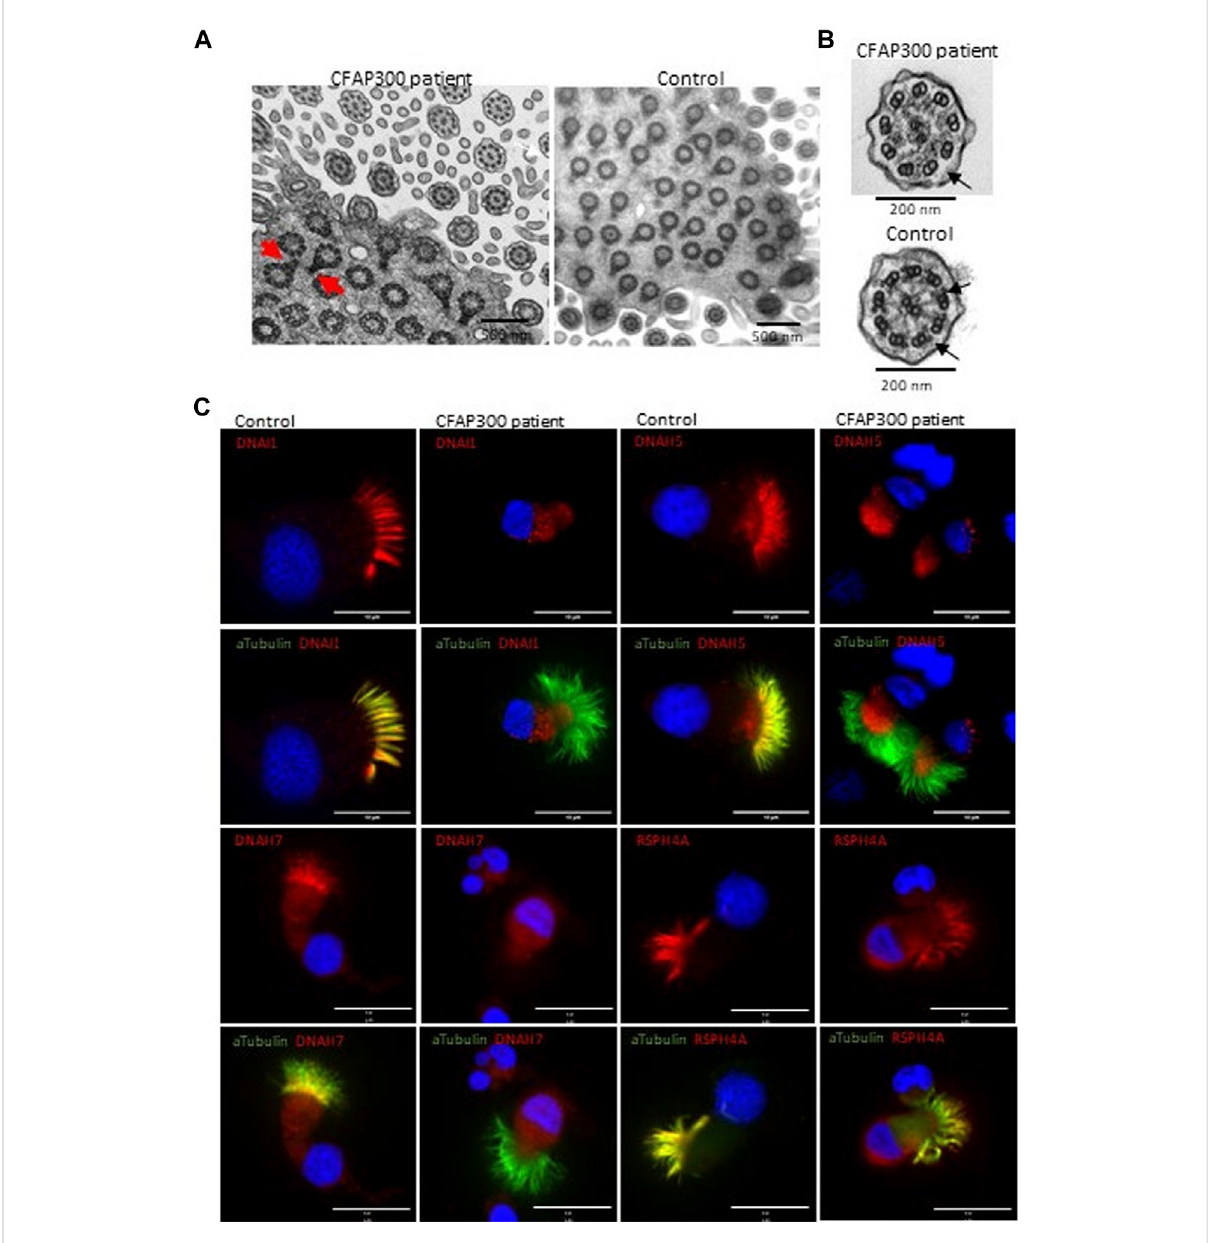
FIGURE 3 Localization of axonemal proteins in airway cilia of a control and PCD patient (patient II-1) with CFAP300 mutations. (A) . High number of cilia cross sections were present in the nasal brushing sample of a PCD patient with CFAP300 c.198_200delinsCC mutations, but the orientation of the basal foot (red arrows) was disorganized compared to control. (B) . The main fi nding in TEM of cilia cross sections in a patient with the CFAP300 variant was lack of dynein arms (black arrows). (C) . ODA (DNAH5 and DNAI1) and IDA (DNAH7) proteins were missing from cilia in the patient airway epithelial cilia, while strong staining is present in the control sample. Radial spoke protein RSPH4A is present in the patient cilia. α Tubulin was used as a marker for cilia and Dapi as a nuclear stain. Scale bar is 10